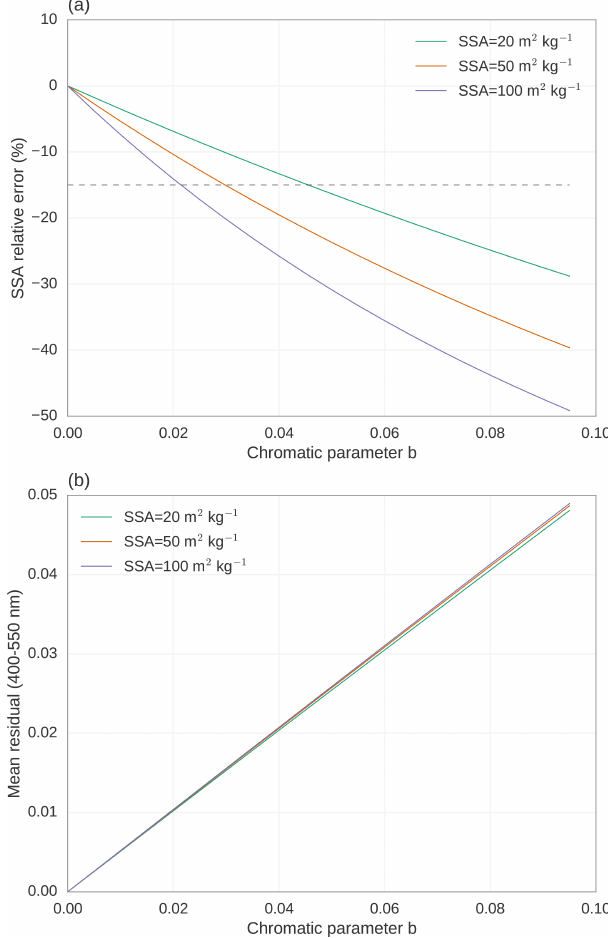
Figure 4. (a) Theoretical calculation of the relative error in SSA due to the chromatic aberration of the spectrometer as a function of the parameter b defined in Eq. (8) for SZA = 60 ◦ . The dashed line shows the 15% target accuracy discussed in the paper. (b) Relation- ship between b and the residual between the observed and estimated albedo averaged over the range